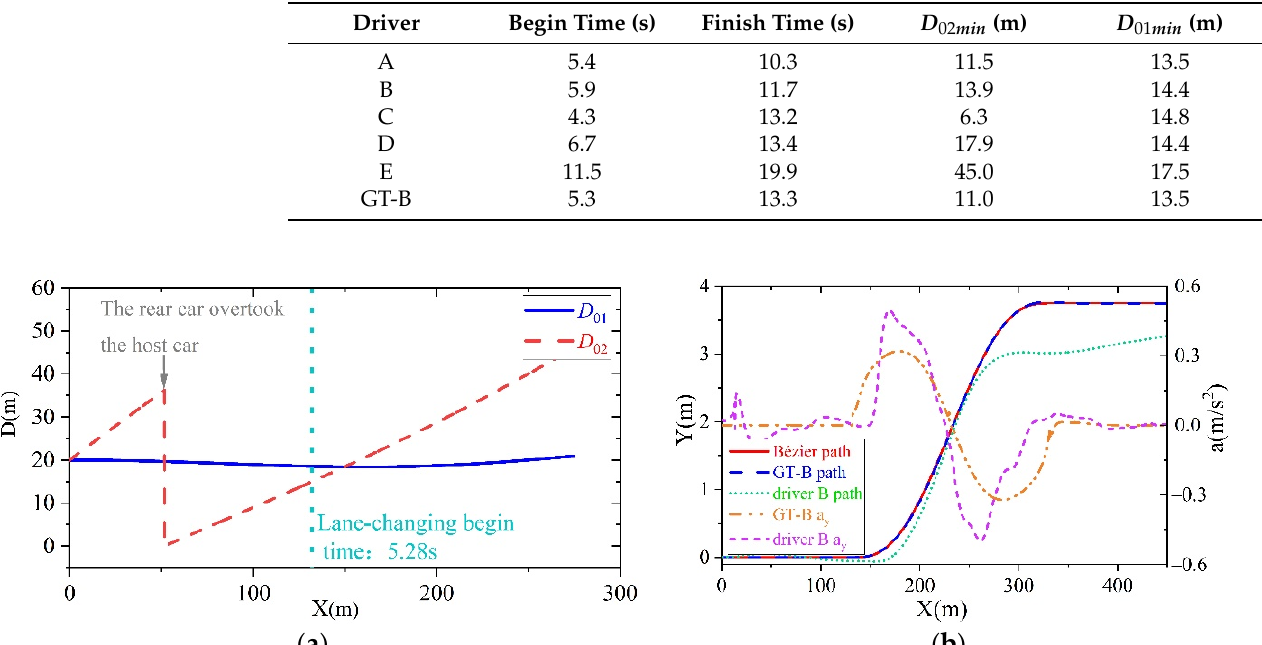
Table 7. Driving parameters of different drivers under Case Ⅰ.